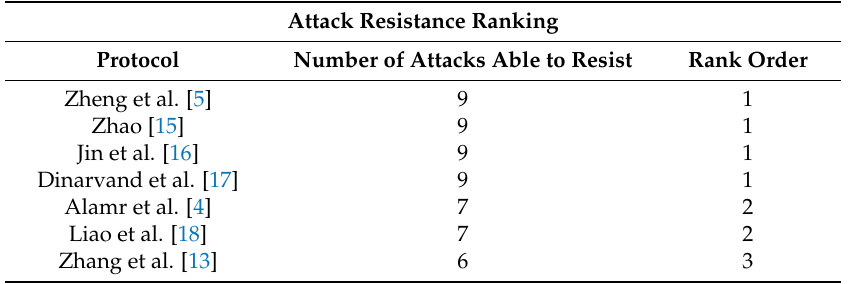
Table 13. Ranking based on the number of different types of attacks each protocol can resist.